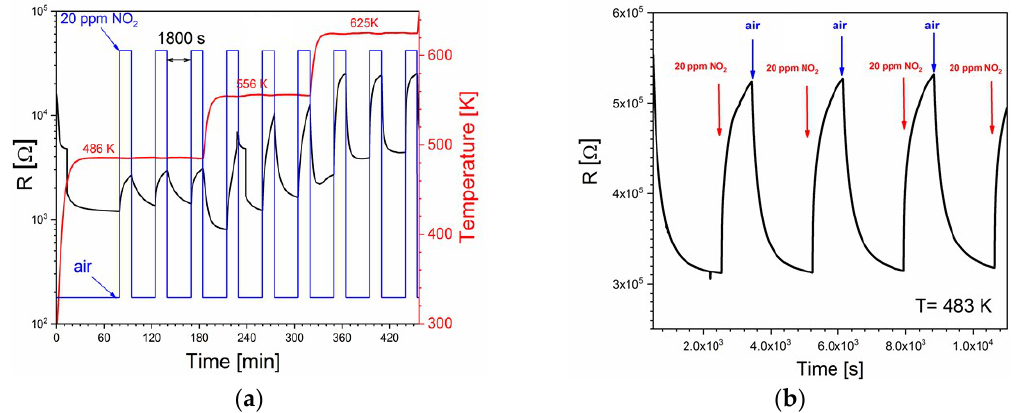
Figure 4. Dynamic changes in the electrical resistance of V 2 O 5 thin film upon interaction with 20 ppm NO 2 , ( a ) at several temperatures; ( b ) at 483 K.